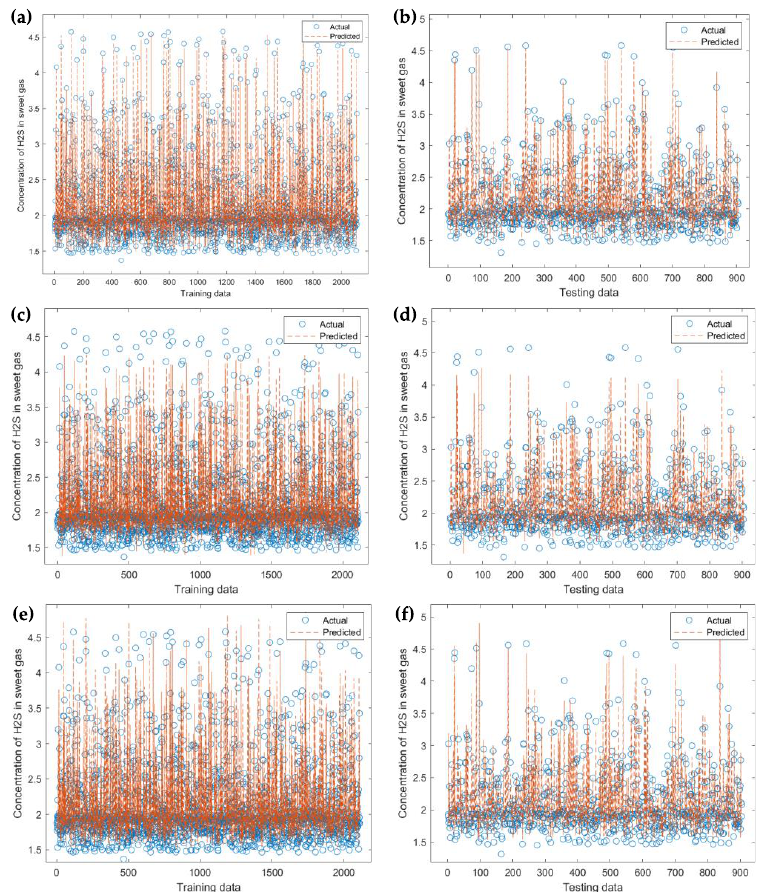
Figure 7. Comparison of actual and predicted concentration of H 2 S in sweet gas of ( a ) training and ( b ) testing of ANN-LM, ( c ) training and ( d ) testing of ANN-SCG, ( e ) training and ( f ) testing of MLR.